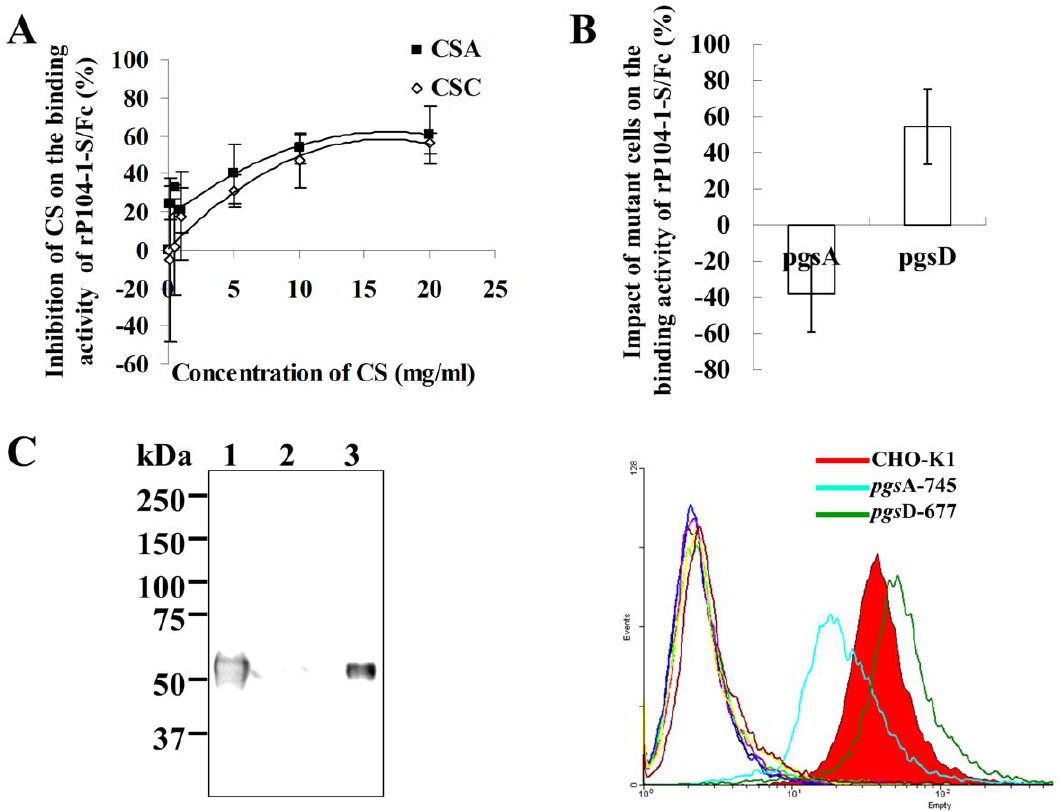
Figure 6. CS is necessary for the adhesion of rP104-1-S/Fc to cells. A. Inhibitory effect of CS on the binding activity of rP104-1-S/Fc to CHO-K1 cells. The inhibitory effect of CSA and CSC on the activity of rP104-1-S/Fc was calculated as the ratio of the geometric mean fluorescence intensity value (GMean): (1-CSA-treated cells/no treated cells) 6 100. The experiment was performed in triplicate. B. Binding activity of rP104-1-S/Fc to CHO-K1 mutant cells. The upper panel shows the ratio of the GMean as (rP104-1-S/Fc-mutant cells/rP104-1-S/Fc-wild cells-1) 6 100; the experiment was performed in triplicate. The lower panel shows the change in fluorescence as evaluated by FACS assay. Different colors indicate the different types of cells and treatments: CHO-K1 (black), Fc-treated CHO-K1 (light green), rP104-1-S/Fc-treated CHO-K1 (red filled histogram), pgs A-745 (dark blue), Fc-treated pgs A- 745 (purple), rP104-1-S/Fc-treated pgs A-745 (light blue), pgs D-677 (yellow), Fc-treated pgs D-677 (dark red), and rP104-1-S/Fc-treated pgs D-677 (dark green). C. Binding of CSA-conjugated beads to rP104-1-S/Fc. CSA-conjugated beads were incubated with rP104-1-S/Fc and then stained with HRP- conjugated anti-mouse antibodies. The bands indicate that rP104-1-S/Fc was co-purified with the CSA-coupled beads. Lane 1, input rP104-1-S/Fc; 2, mock beads incubated with rP104-1-S/Fc; 3, CSA-treated beads incubated with rP104-1-S/Fc. The molecular masses in kDa are shown on the